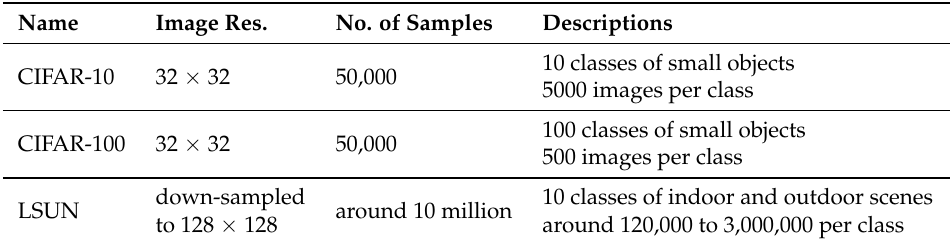
Table 2. Datasets used in the